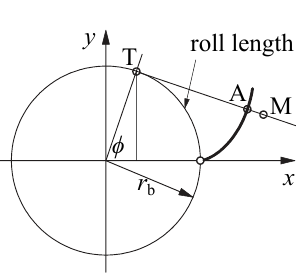
Figure 6. The parameters and relations used for the transformation to the roll length distance. M—measured points, A—points on the ideal involute, T—points on the base circle and the formed